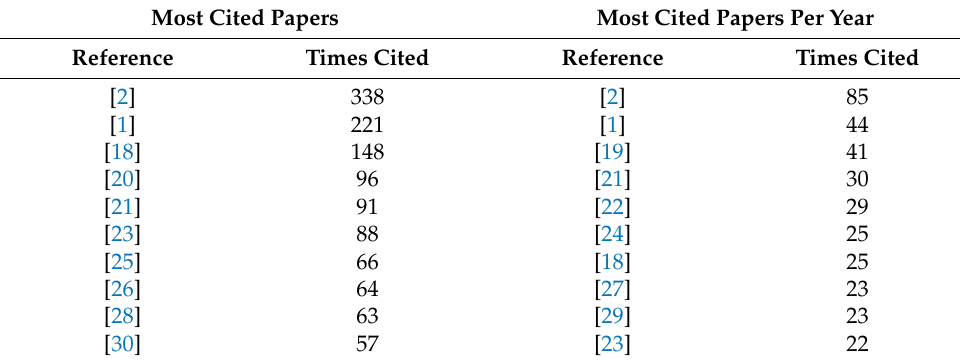
Table 1. Ten most cited papers and top 10 papers with most citations per year. Most Cited